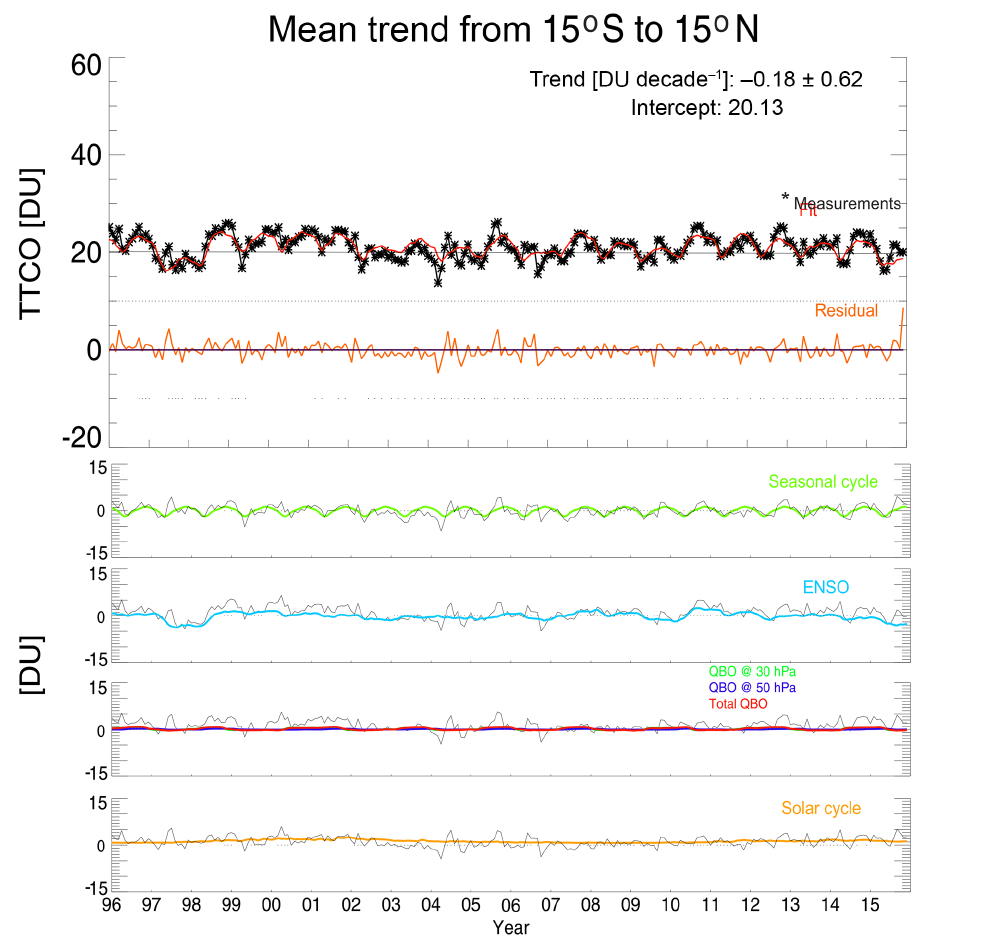
Figure 4. Mean tropical tropospheric ozone trends between − 15 ◦ S to 15 ◦ N for the period 1996 to 2015. Top: the multivariate linear trend (black), the fit (red) and the residual (orange) are plotted. The mean tropical tropospheric ozone trend is equal to − 0.18 and the 2 σ uncertainty in the trend is ± 0.62DUdecade − 1 . The next panels show the harmonic functions (green), ENSO (light blue), QBO (red) and solar solar (orange). Overlaid in black for all proxies are the time series with all fit terms removed except the particular fit